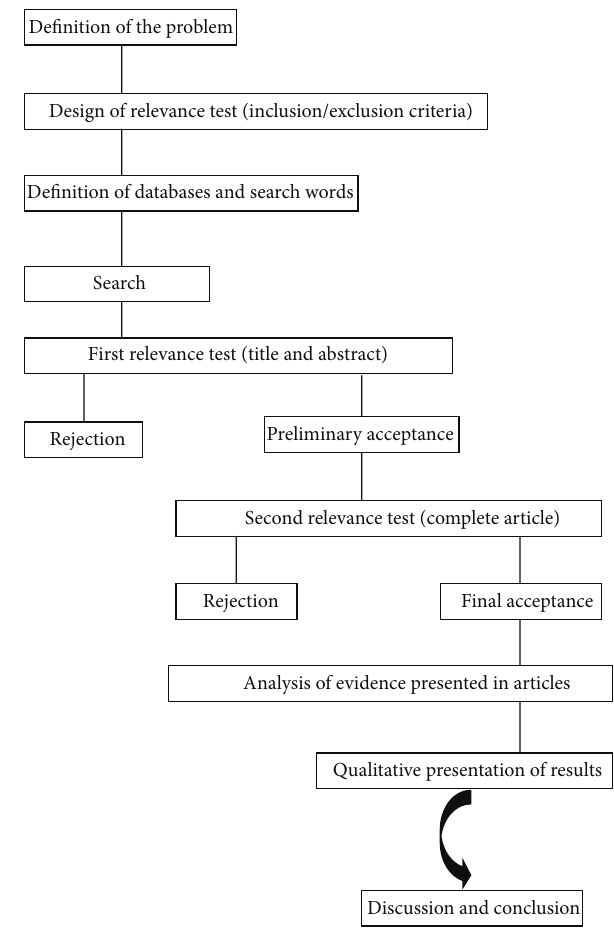
Figure 1: Flowchart of the systematic